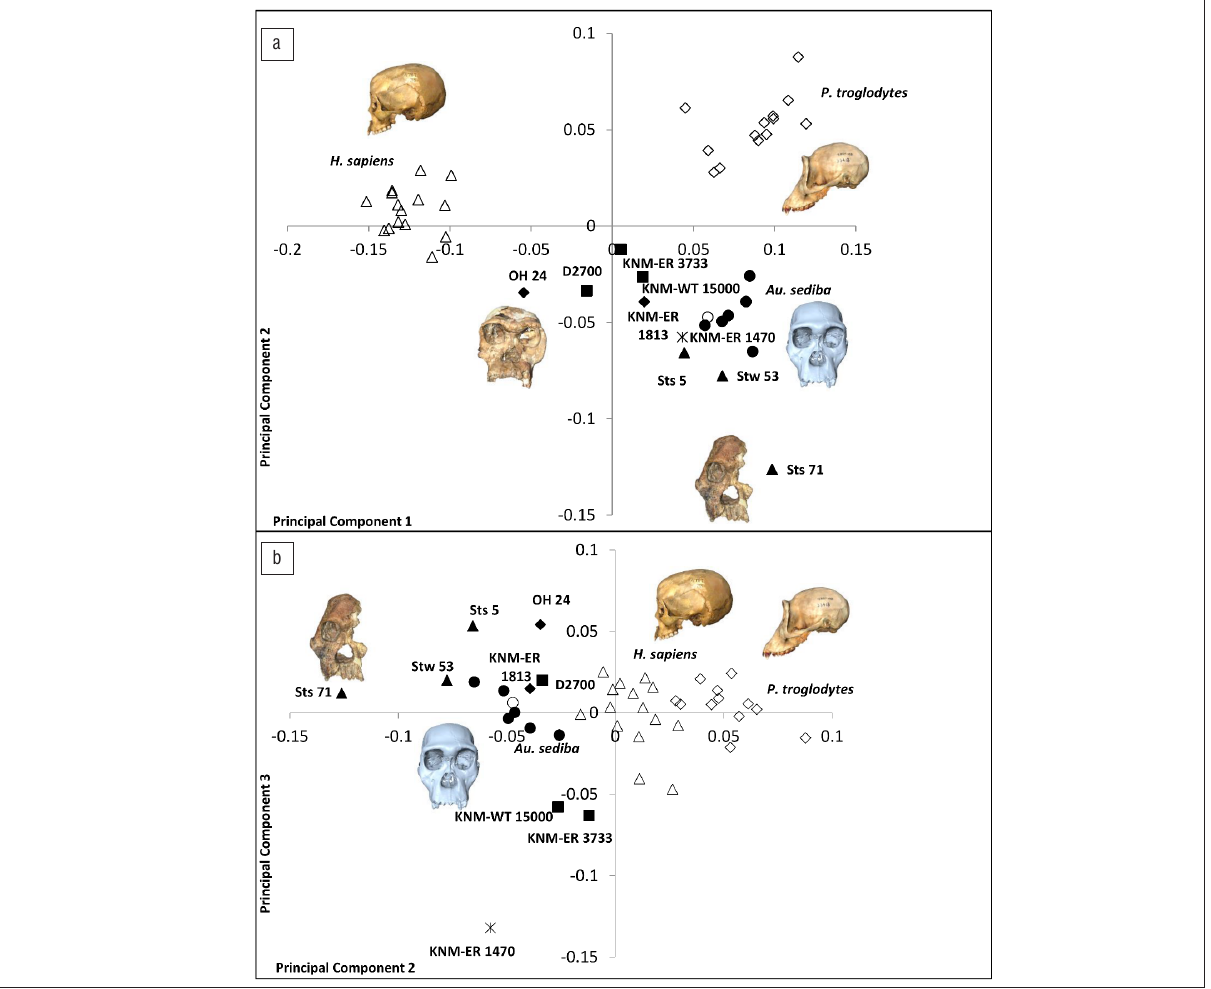
Figure 3: Major (principal component) axes of cranial shape for hominoids, including simulated adult crania of Australopithecus sediba . (a) Principal components 1 and 2 (58.7% and 11.0% of variance, respectively). (b) Principal components 2 and 3 (11.0% and 6.5% of total variance,